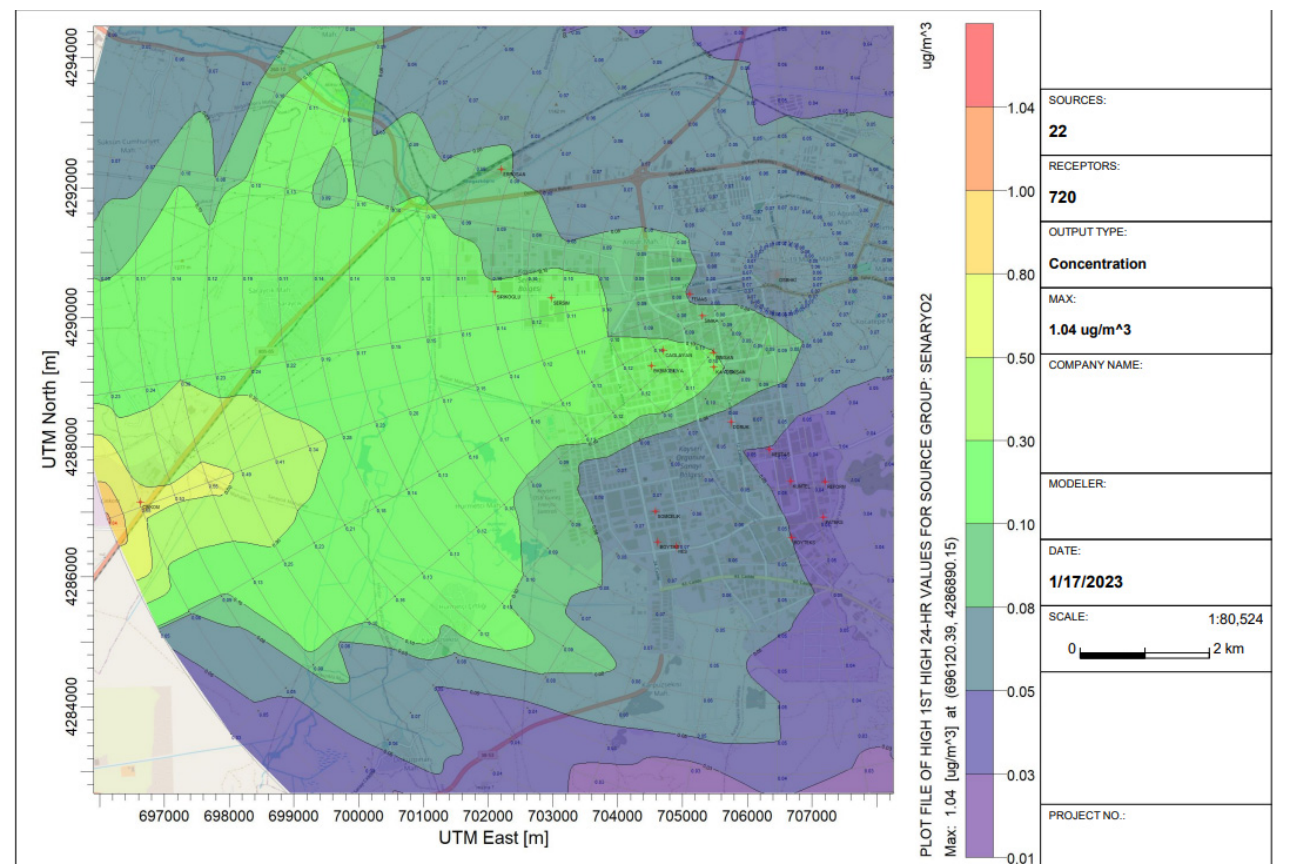
Figure 7. The AERMOD dispersion map created for scenario 2 (Red crosses represent the facilities considered in the model). Table 4. AERMOD modeled PM 10 levels, peak receptor coordinates, and dates/hour for scenarios 1 and